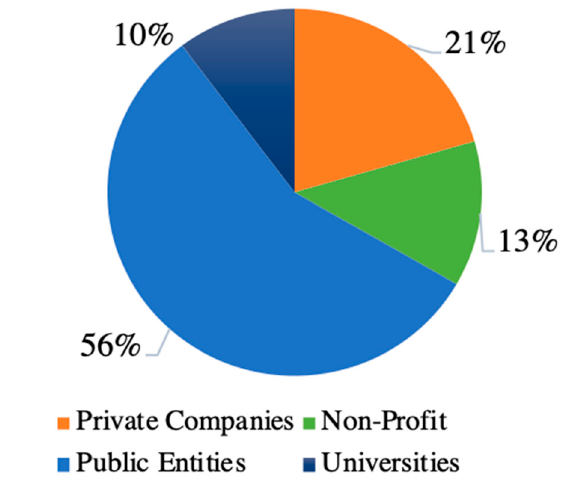
Figure 3. Share of organizations by type.